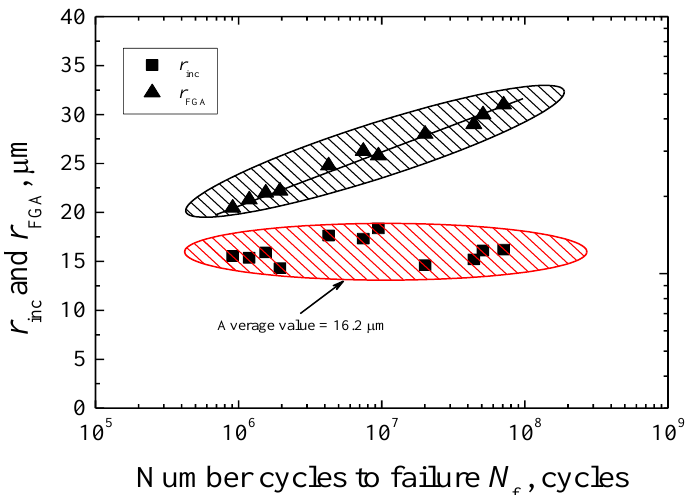
Figure 8. Relationships between radius of inclusion ( r inc ), radius of FGA ( r FGA ), and N f .